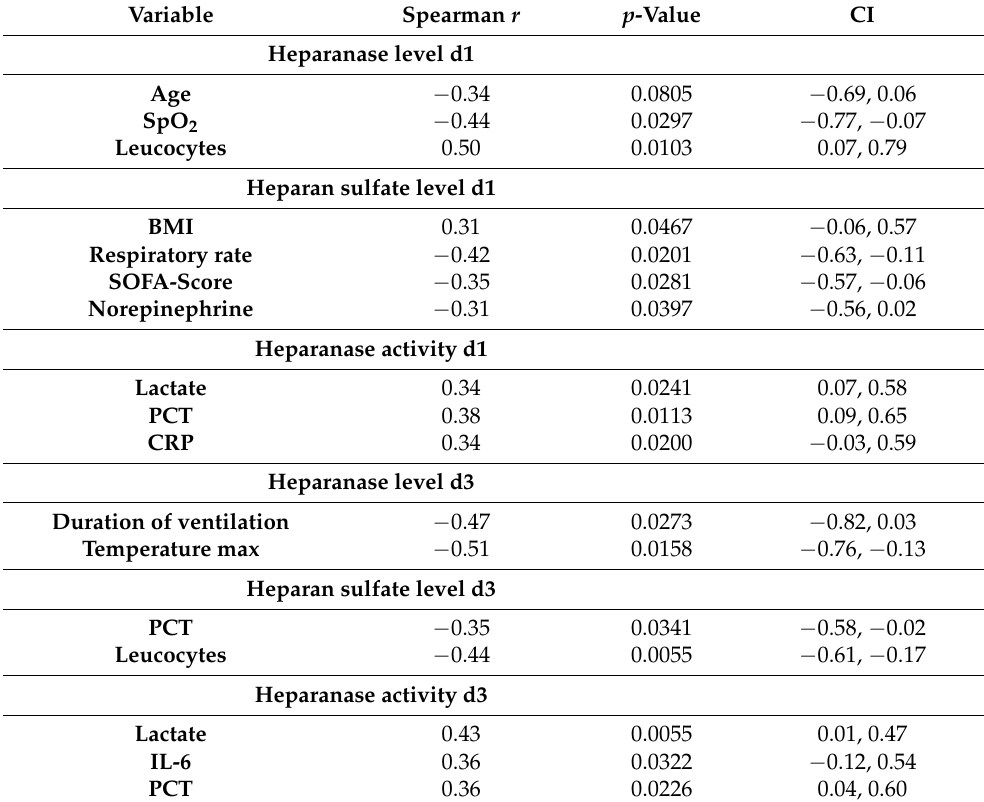
Table 2. Significant correlations between biomarkers and clinical